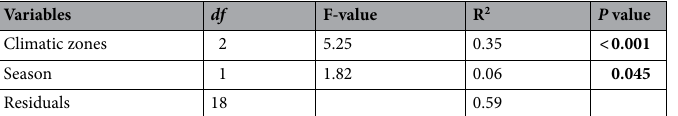
Table 2. Relative importance of different seasons (autumn and winter) and three climatic zones on the airborne fungal community composition in industrial grain mills, as revealed from the PERMANOVA analysis. Bold values represent differences significant at a P -value <